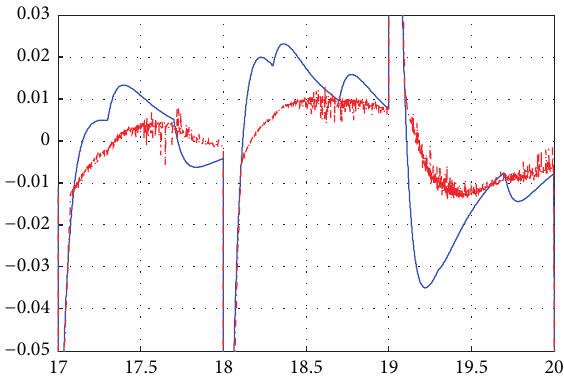
Figure 6: The zoom on the errors between unknown input and its